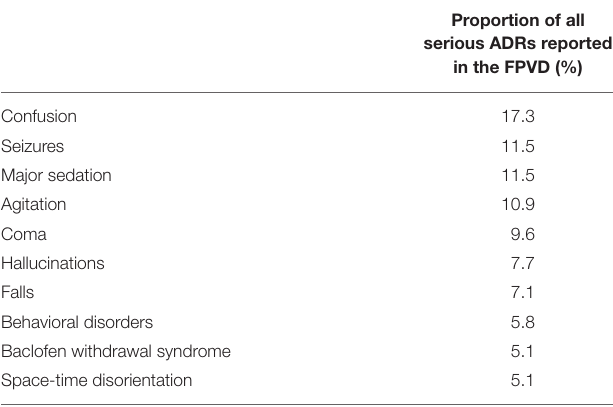
TABLE 2 | Ten most frequent serious ADRs reported in the FPVD in patients treated with baclofen for AUD.